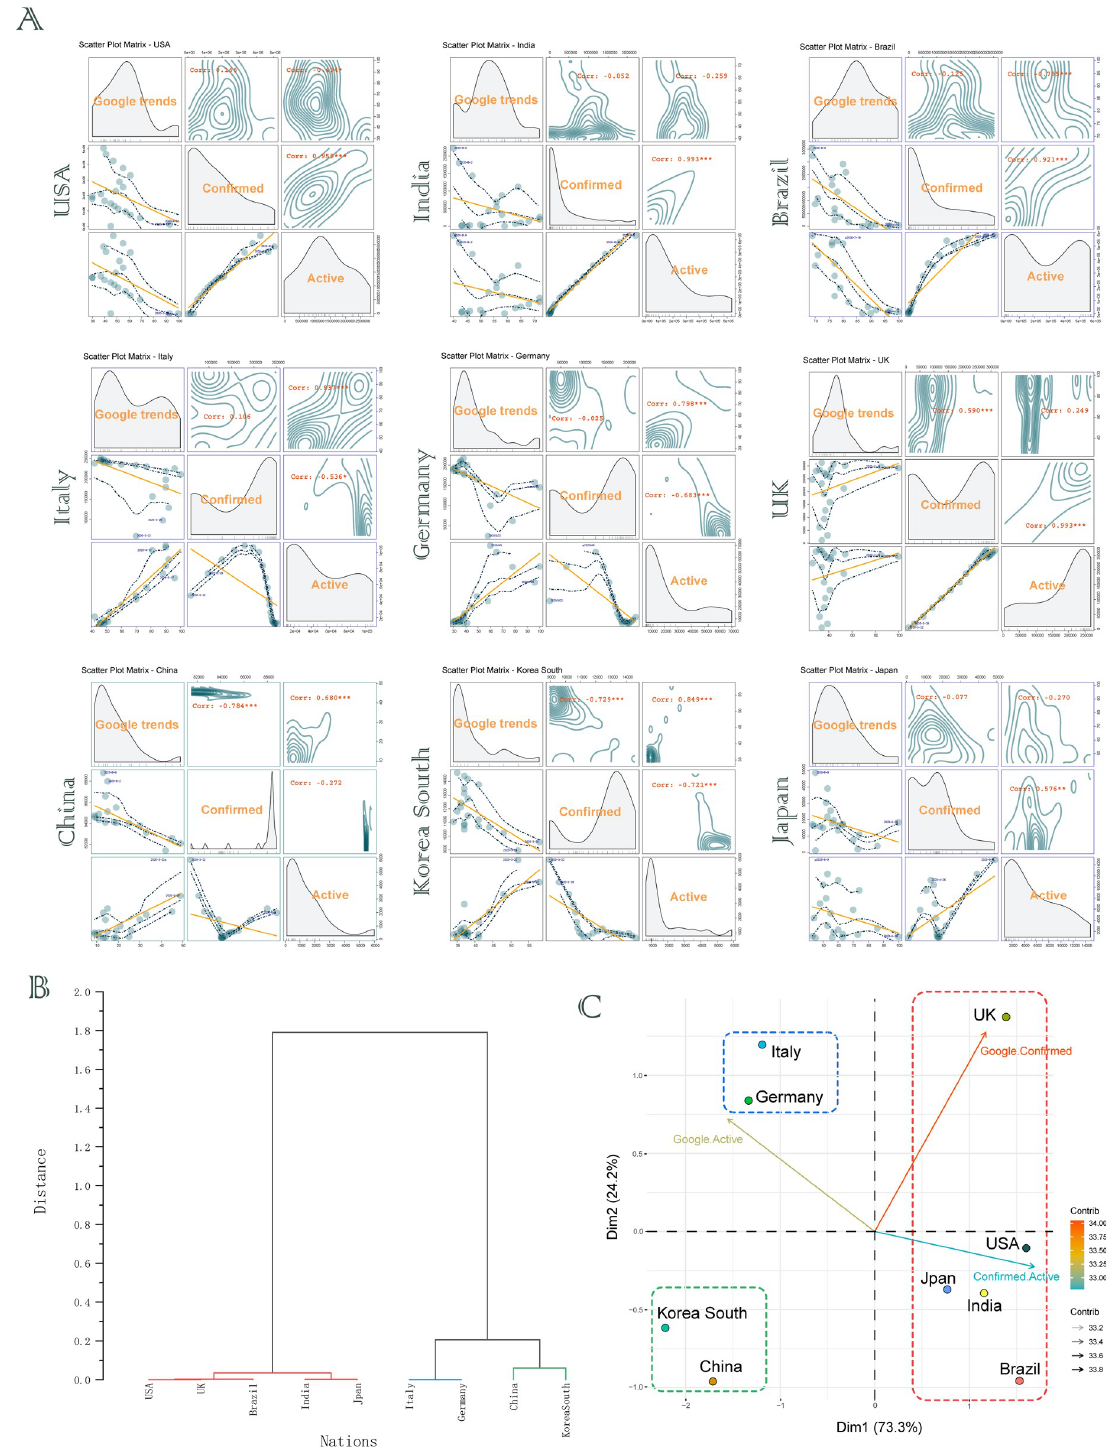
Fig 4. Digital epidemiology is a new way to understand "global collaboration-pandemic control" uncertainty. (A) Matrix analysis of correlation of GT (search keyword "lockdown") and WHO epidemiologic data (the number of confirmed cases and active cases respectively). (B) Hierarchical clustering analysis of above correlation. (C) PCA analysis of above correlation. The color of the dashed box represents different hierarchical clusters. Corr : correlation coefficient, � p < 0.05, �� p < 0.01, ��� p < 0.001.